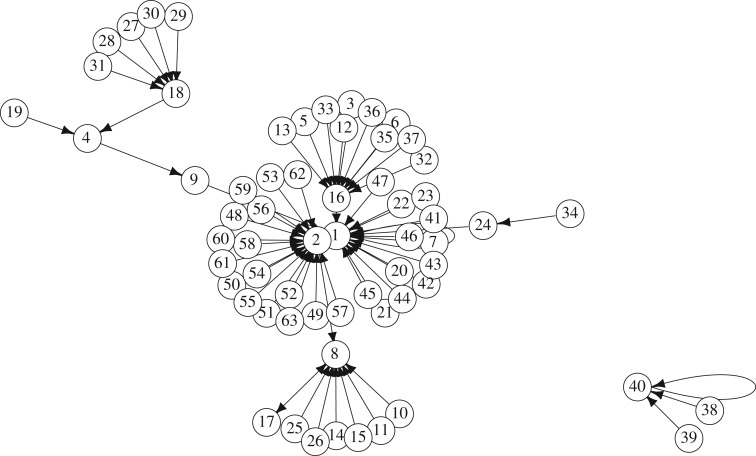
Graph of g at t = 41.